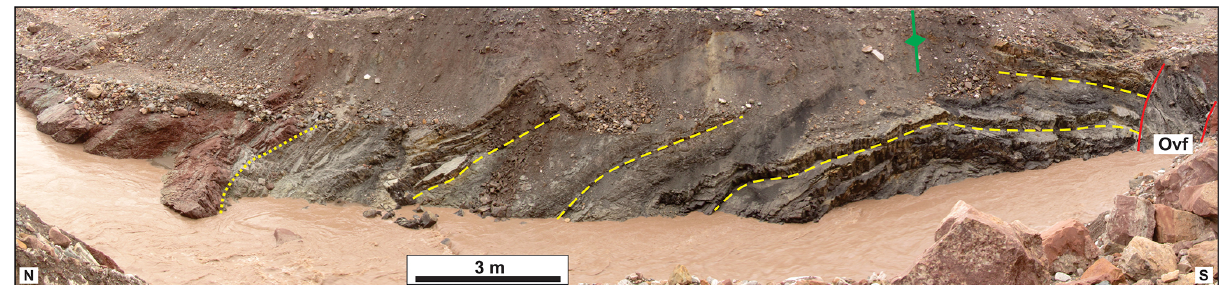
Figure 6. Eastward view of folded sedimentary strata (bedding in dashed yellow) forming an E–W- to WNW–ESE-trending, open, upright anticline (green) in the hanging wall of the Overgangshytta fault (red; Ovf), along the southern portion of the riverbed (Fig. 4). Note the boundary (conformity?) between grey sandstones and coaly shales of the Billefjorden Group and red sandstones and shales of the Hultberget Formation in dotted yellow. See Fig. 4 for